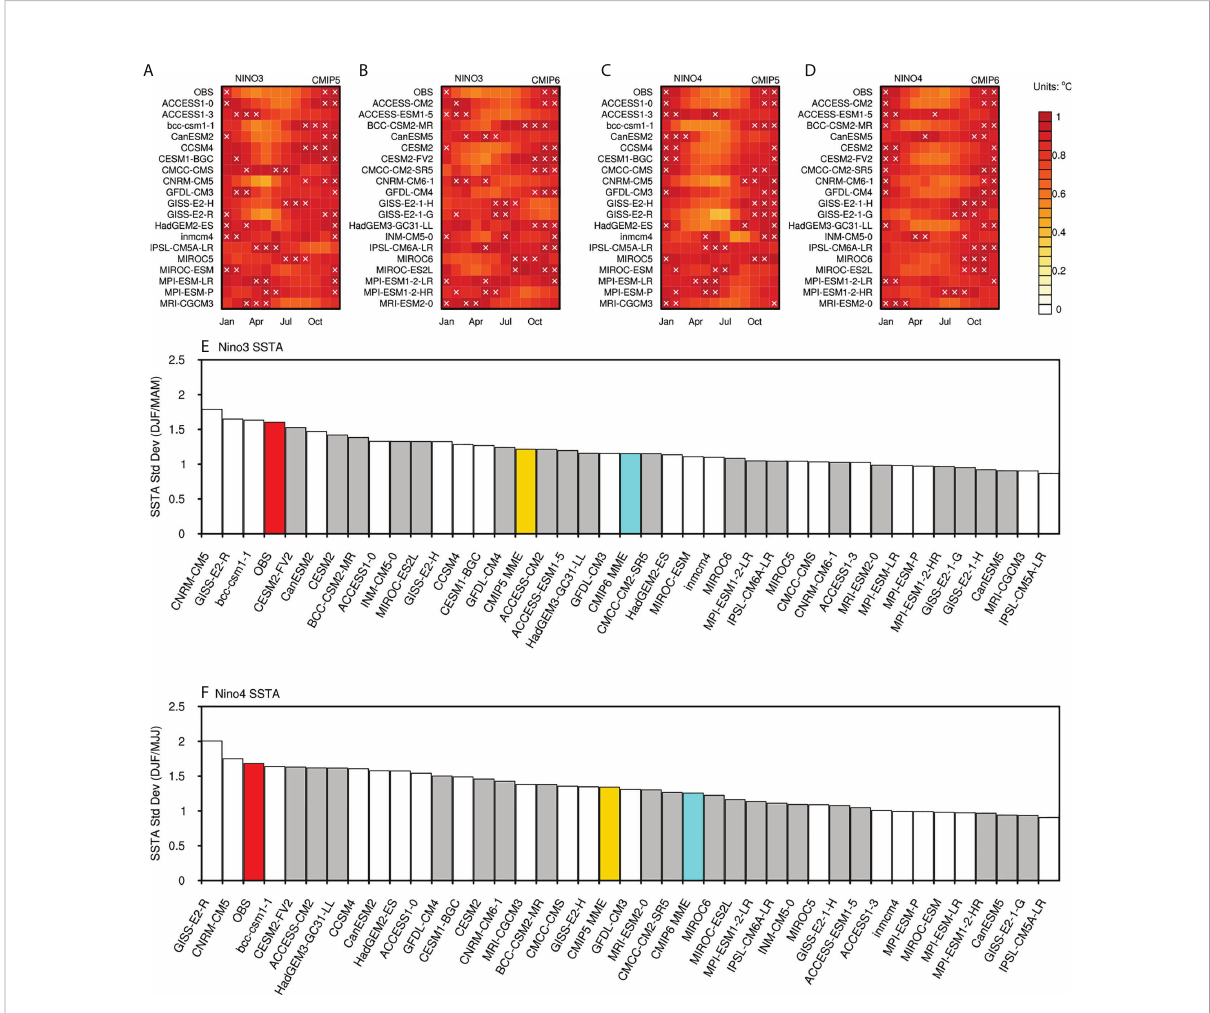
FIGURE 4 Seasonal phase-locking behavior in CMIP models. Standard deviation of Monthly Niño3 SSTA and Niño4 SSTA for observational data and CMIP5 and CMIP6 models, normalized by their maximum value (A – D) . The white crosses indicate the largest 3 monthly standard deviation values in each model. Phase locking index for Niño3 SSTA (E) and Niño4 SSTA (F) in observation and CMIP models. The red bar represents the observation. The white and grey bars denote different models in CMIP5 and CMIP6, respectively. The yellow and blue bars indicate the multi- model mean result in CMIP5 and